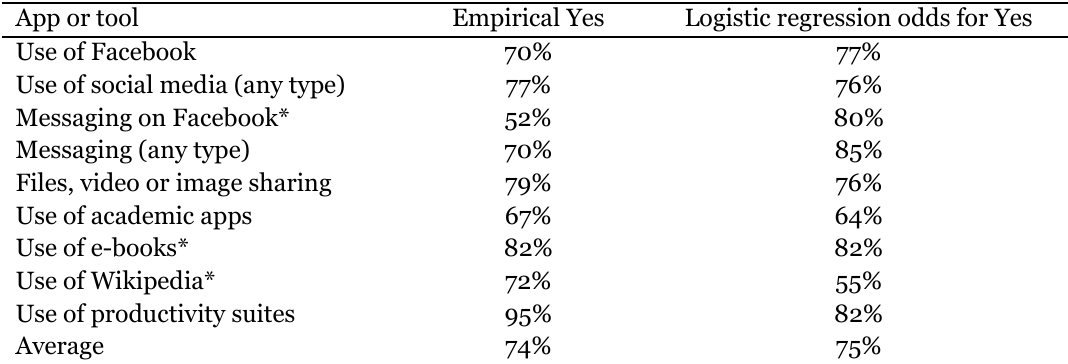
Use of Apps and Tools in an Academic Context App or tool Empirical Yes Logistic regression odds for